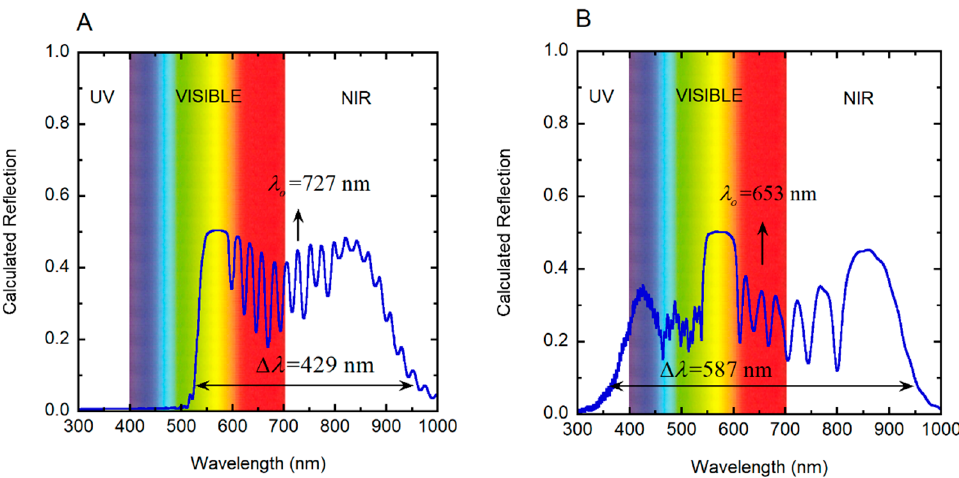
Figure 11. Calculated total reflection spectra of cuticles of ( A ) golden-like C. chrysargyrea and ( B ) silver-like C. chrysargyrea illuminated with non-polarized normally incident light. NIR: Near infrared; UV: Ultraviolet.